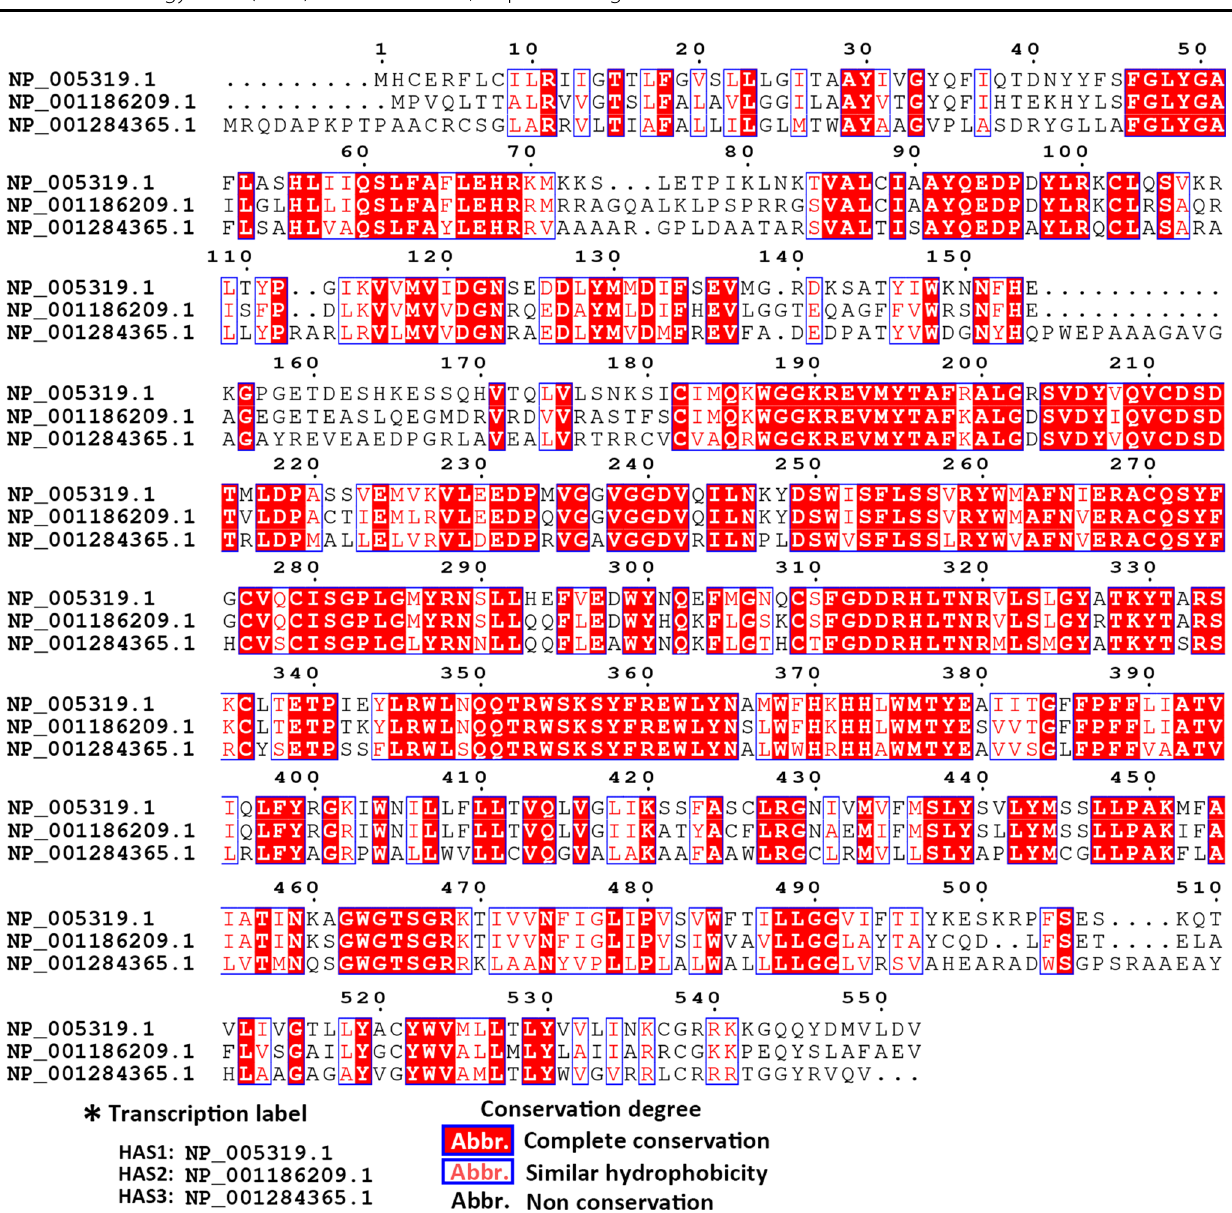
Fig. 2 The amino acid sequence alignment of three hyaluronan synthases. CLUSTAL X was used for analyzing the multiple alignments of the amino acid sequence of HAS1, HAS2, HAS3. Then the result of alignment was visualized by ESPript 3.0. The transcript label listed on the left was the code from NCBI database of the amino acid sequence of HAS1, HAS2, and HAS3, respectively. The amino acid abbreviation in white color with red background presents the aligned sequences are identical, and words in red color present the aligned sequences have similar hydrophobicity, hydrophilicity or similar side chain. Word in black presents the aligned sequences that are not